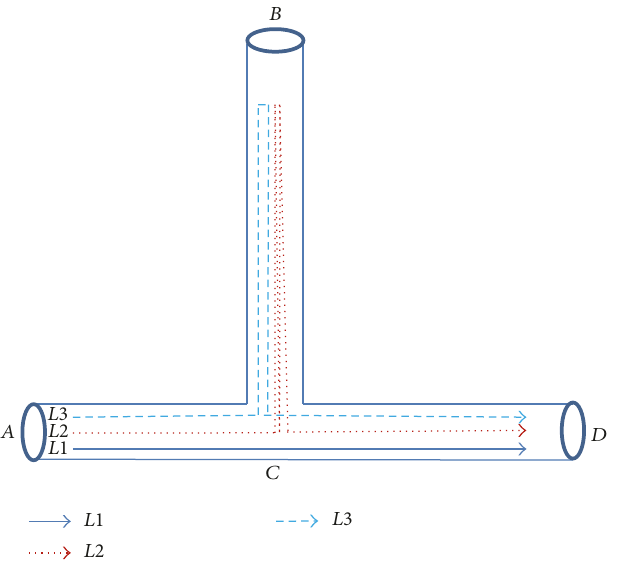
Figure 3: Branch circuit of power line communication.